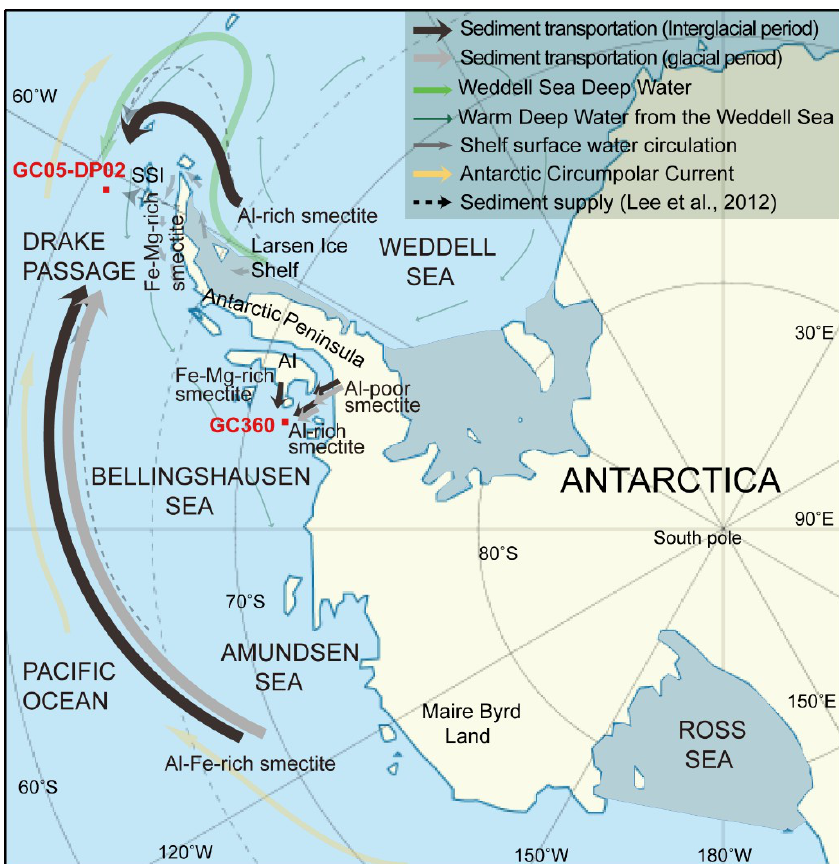
Figure 8. Schematic diagram showing possible transport routes of fine-grained detritus. Gray and black arrows indicate smectite transport during glacial and interglacial periods, respectively. Ocean circulation given as in Figure 1. SSI = South Shetland Island, AI = Alexander Island.